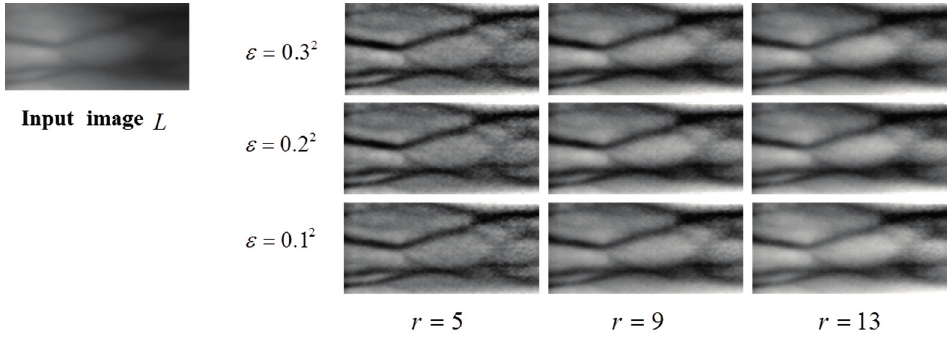
Figure 5. Outputs of guided filter with different parameters ( , ) r ε . The guidance image is identical to the input image.